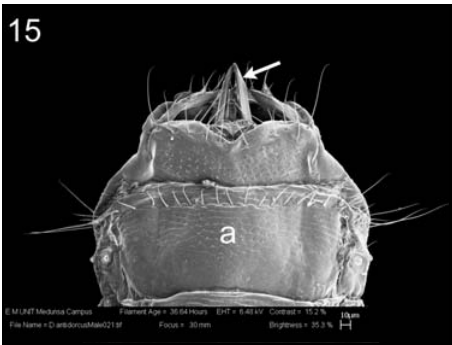
Fig. 15. The male genital area (arrow) = parameres, (a) =